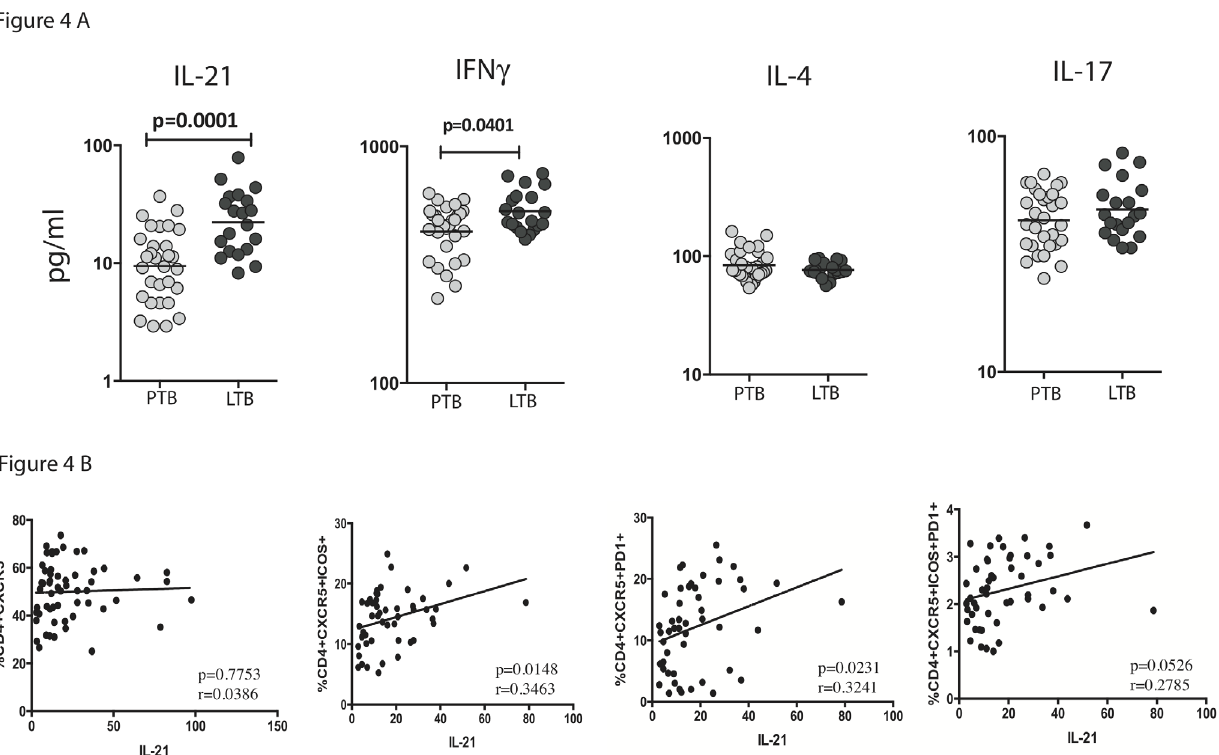
Figure 4. Diminished circulating IL-21 levels in PTB is associated with decreased spontaneous frequencies of Tfh subsets. (A) The circulating levels of Tfh associated cytokines - IL-21, IFN c , IL-4 and IL-17 were measured by ELISA in PTB and LTB individuals. Results are shown as scatter plots with each circle representing a single individual. P values were calculated using the Mann-Whitney U test. (B) The correlation between circulating IL-21 levels and Tfh subsets in shown as scatter plots in PTB individuals. P values were calculated using Spearman rank